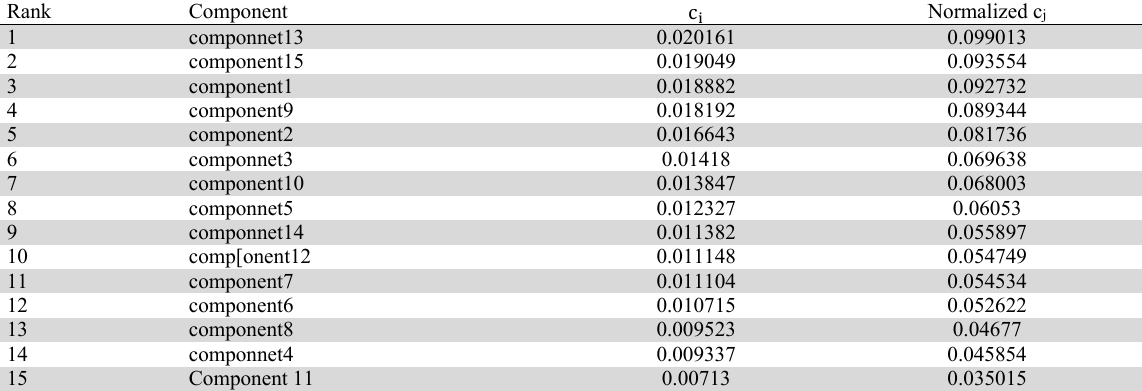
Criticality of the code smell with subjective method